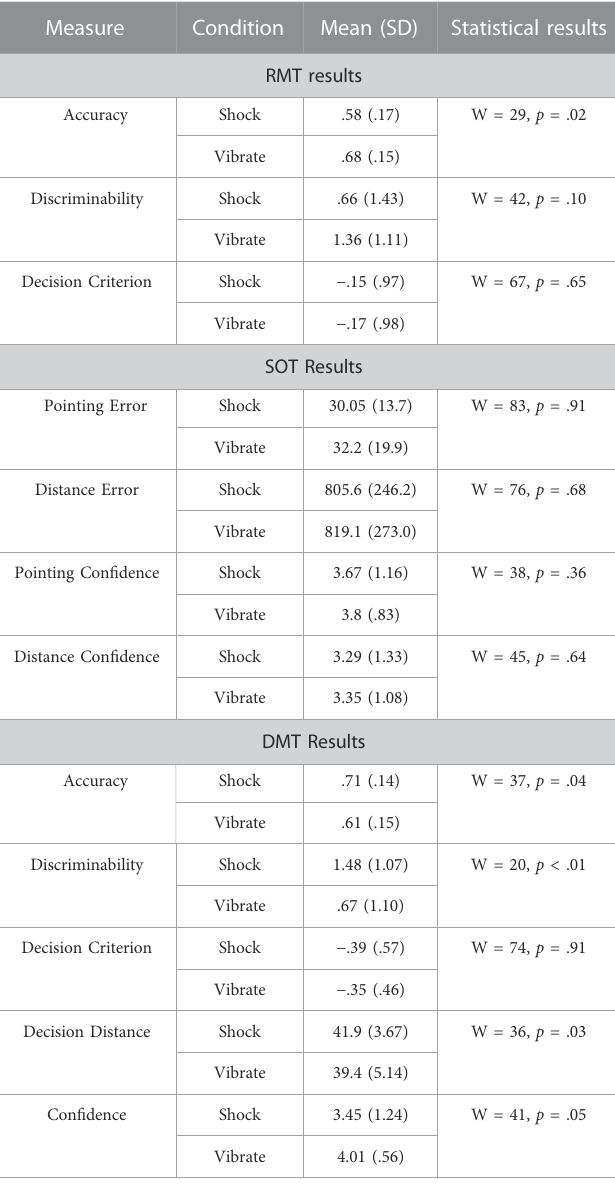
TABLE 4 Upper: Mean and standard deviation accuracy, discriminability (d-prime), and decision criterion (c) scores from the RMT, along with results from Wilcoxon signed rank tests comparing shock to vibrate. Middle: Mean and standard deviation absolute pointing and distance error, and pointing and distance con fi dence from the SOT, along with results from Wilcoxon signed rank tests comparing shock to vibrate. Lower: Mean and standard deviation accuracy, discriminability (d-prime), decision criterion (c), decision distance, and con fi dence from the DMT, along with results from Wilcoxon signed rank tests comparing shock to vibrate.